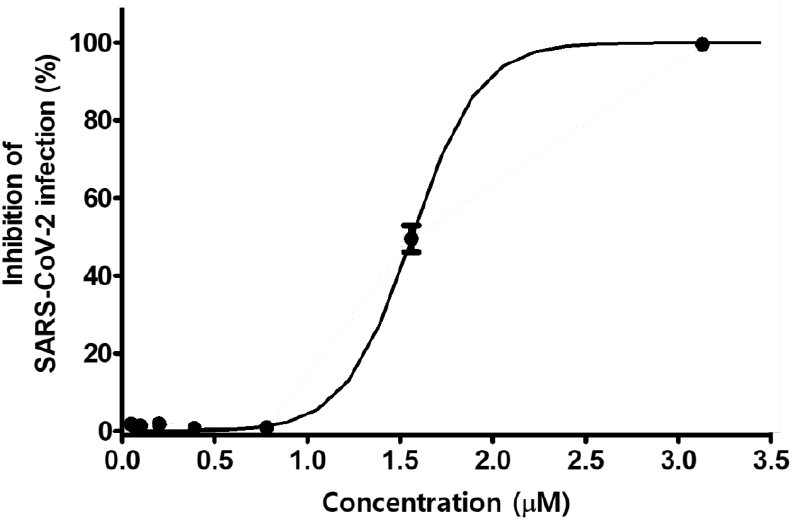
Figure 6. Mulberrofuran G (MG) inhibits the infection of a clinical isolate of SARS-CoV-2 in Vero cells. Vero cells were cultured in 384-well plates (1.2 × 10 4 cells/well) for 24 h. Cells treated with serial dilutions of MG were infected with SARS-CoV-2 (MOI 0.0125) and incubated at 37 ◦ C for 24 h. The cells were then stained with anti-SARS-CoV-2 nucleocapsid (N) primary antibody, Alexa Fluor 488-conjugated goat antirabbit IgG secondary antibody, and Hoechst 33342.